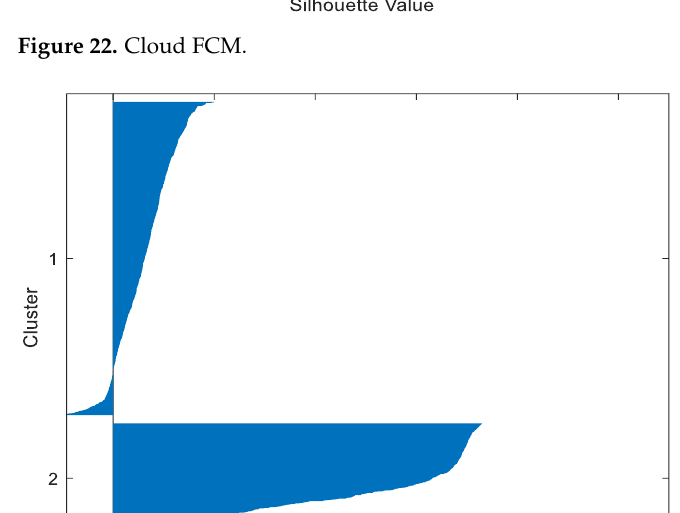
Figure 22. Cloud FCM.